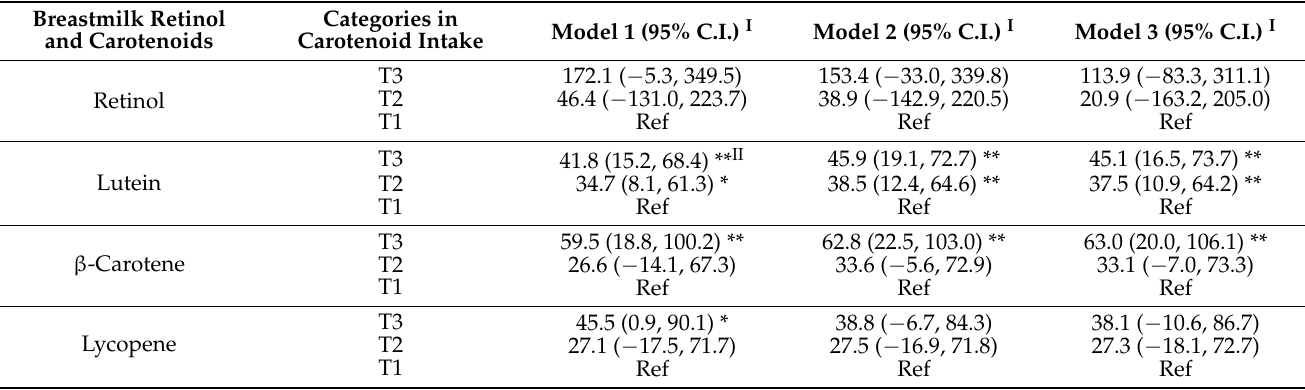
Table 3. Regression coefficients on the association between carotenoid intake and the levels of breastmilk retinol and carotenoids.